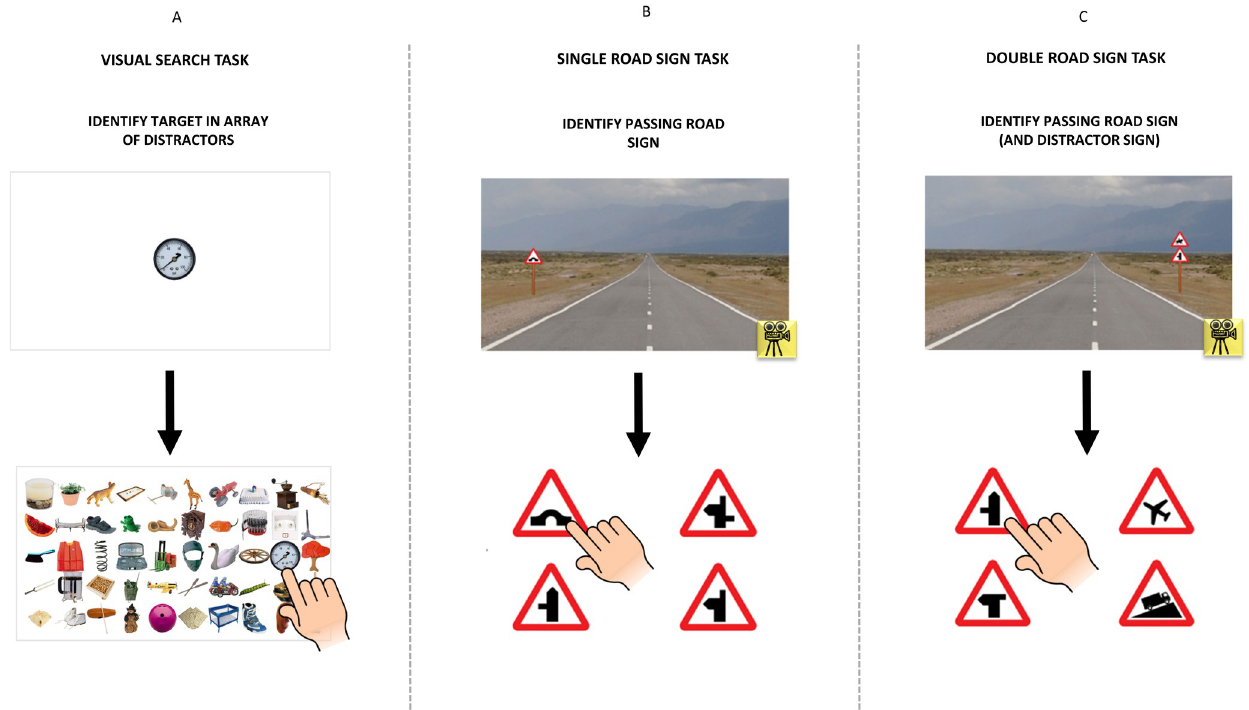
Fig 1. Task procedures. A schematic showing the task procedures for the visual search task (A) and both road sign tasks (B-C).